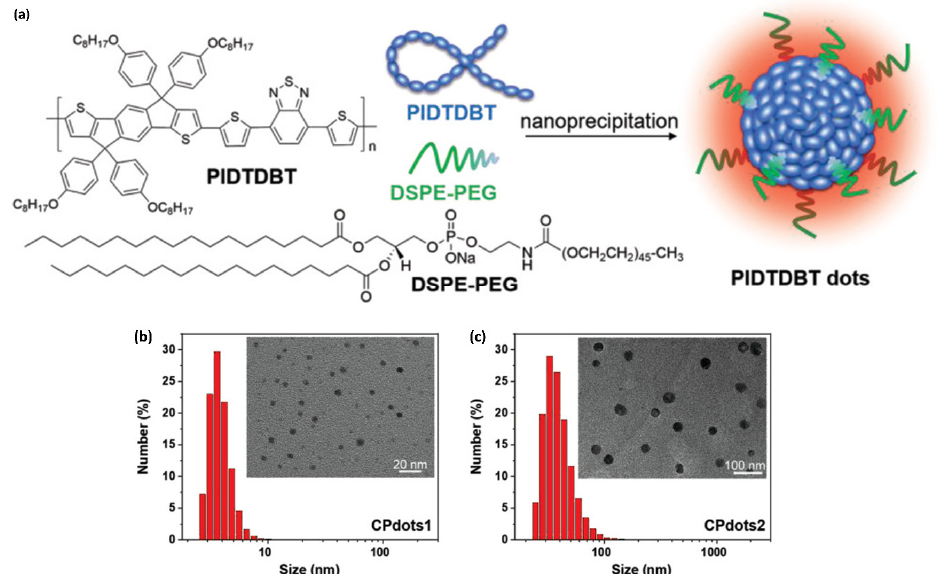
Figure 20. ( a ) Chemical structures of probe 48 and DSPE-PEG polymers and a schematic illustration for probe 48 Pdots synthesis. Hydrodynamic size distributions of DSPE-PEG:probe 48 weight ratios (first panel) and under 808 nm laser excitation with a 1020 nm LP filter (second panel), 1100 nm LP of ( b ) 10:1 and ( c ) 2:1 in aqueous media. The insets are the corresponding TEM images of 10:1 and filter (third panel), 1250 nm LP filter (fourth panel), and 1312 nm LP filter (fifth panel). ( b ) Whole-body imaging of live mice intravenously injected with probe 24 Pdots in supine ( left ) and prone ( right ) positions with a 1100 nm LP filter. ( c ) Whole-body imaging of live mice intravenously injected with probe 26 Pdots in supine ( left ) and prone ( right ) positions with a 1250 nm LP filter. ( d ) Whole-body imaging of live mice intravenously injected with ICG in supine ( left ) and prone ( right ) positions with a 1250 nm LP filter. ( e ) Enlarged view of the mouse hindlimb vasculature in the green squares of ( b ) ( upper panel) and ( c ) ( bottom panel), respectively. ( f ) Cross-sectional intensity profiles along the green lines in ( e ) for probe 24 Pdots ( left ) and probe 26 Pdots ( right ), respectively. ( g ) Enlarged view of the area close to the spinal cord in the red squares of ( b ) ( upper panel) and ( c ) ( bottom panel), respectively. ( h ) Cross-sectional intensity profiles along the red lines in ( g ) for probe 24 Pdots ( left ) and probe 26 Pdots (right), respectively. ( i ) NIR-II fluorescence imaging of the wild-type C57BL/6 mouse brain vasculature after intravenous injection of probe 24 Pdots ( left , 1100 nm LP filter), probe 26 Pdots ( middle , 1250 nm LP filter), and ICG ( right , 1250 nm LP filter). ( j ) NIR-II fluorescence imaging of the ND2:SmoA1 mouse brain vasculature after intravenous injection of probe 26 Pdots (1250 nm LP filter). ( k ) Accumulation of probe 24 Pdots ( upper panel in the inset) and probe 26 Pdots ( bottom panel in the inset) in the major excised organs at 24 h post-injection. Their corresponding quantitative mean fluorescence intensities are also plotted. The scale bars are 10 mm, 10 mm, and 5 mm in ( b ), ( c ), and ( i ), respectively. Reprinted with permission from Ref. [8]. Copyright 2020, John Wiley and